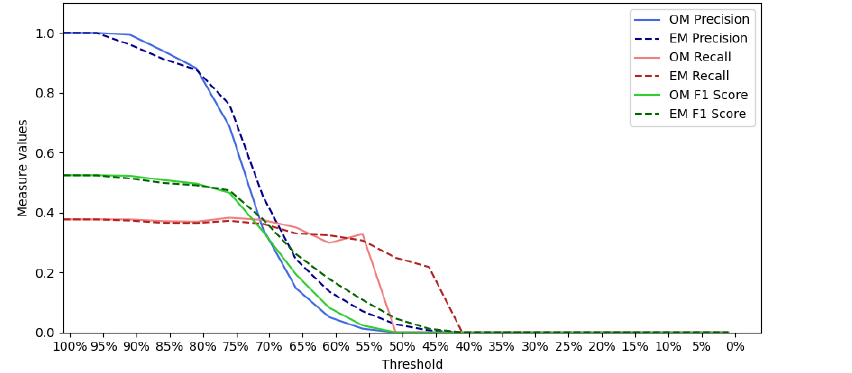
Figure 21. All tweets with hashtags from PHEME dataset by